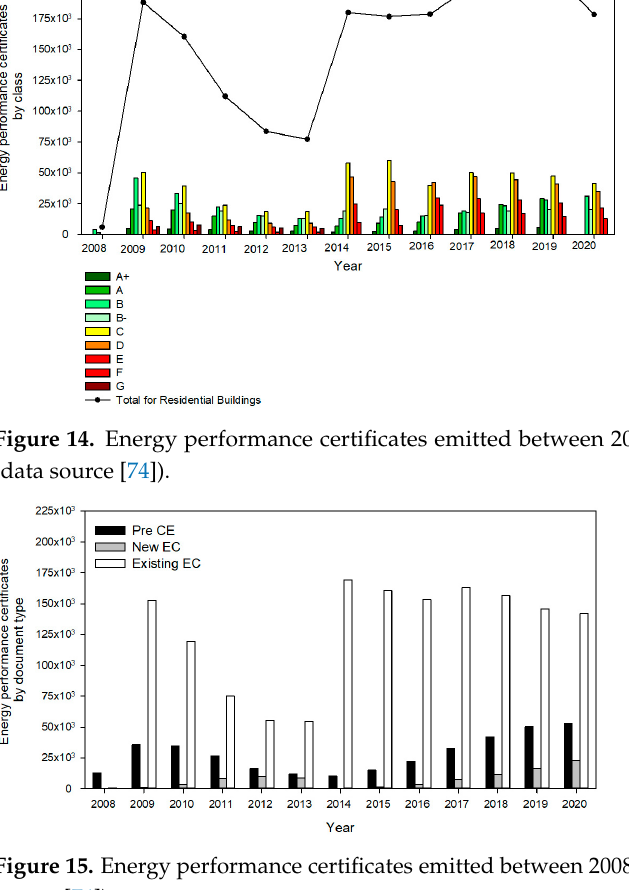
Figure 15. Energy performance certificates emitted between 2008–2020 in Portugal by CE type (data source [74]).